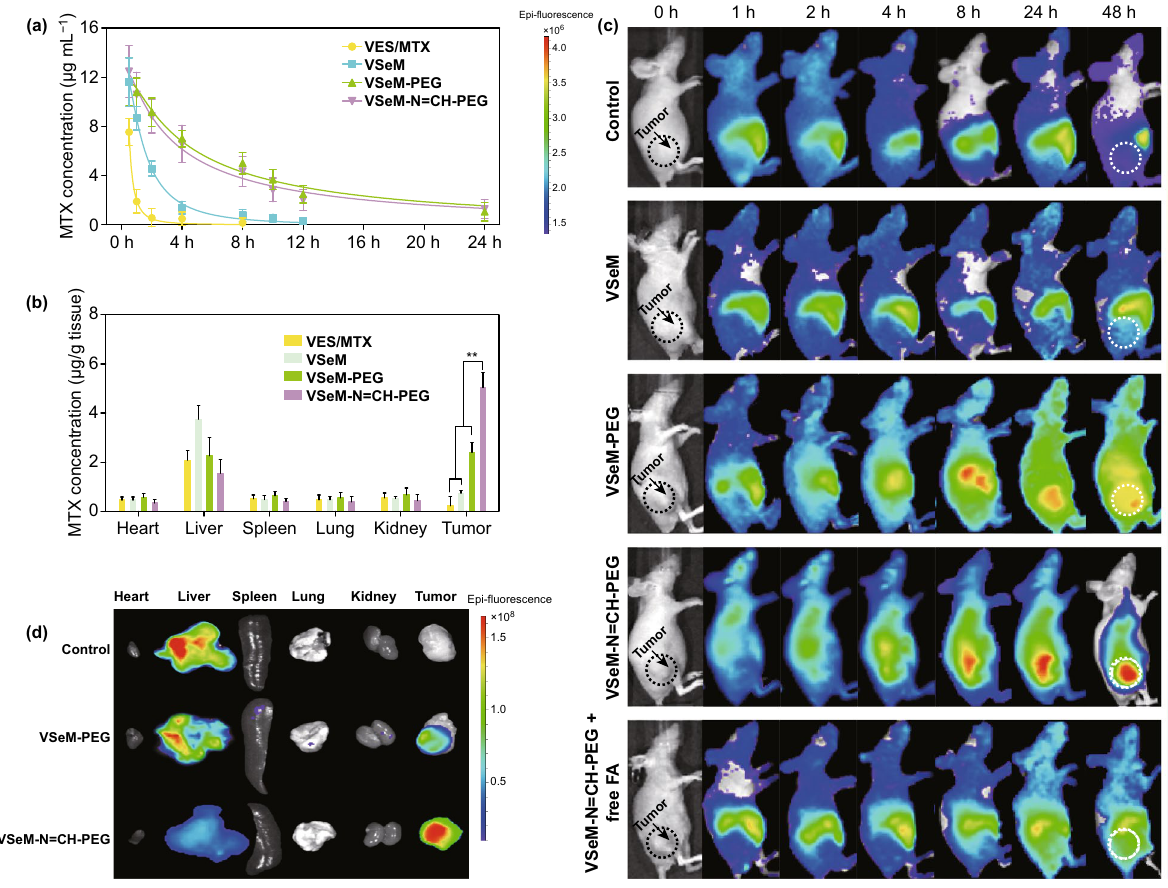
Fig. 4 In vivo pharmacokinetics, biodistribution, and tumor accumulation of VSeM-N=CH-PEG. a Pharmacokinetics and b biodistribution of HeLa tumor-bearing mice after intravenous injection of DiR-labeled VES/MTX, VSeM, VSeM-PEG, and VSeM-N=CH-PEG. DiR was used as a control. c Time-lapsed NIR fluorescence imaging of HeLa tumor-bearing mice. d NIR fluorescence imaging of excised normal and tumor tis- sues at 48 h post-injection. Error bars indicate SD ( n = 3). ** P <